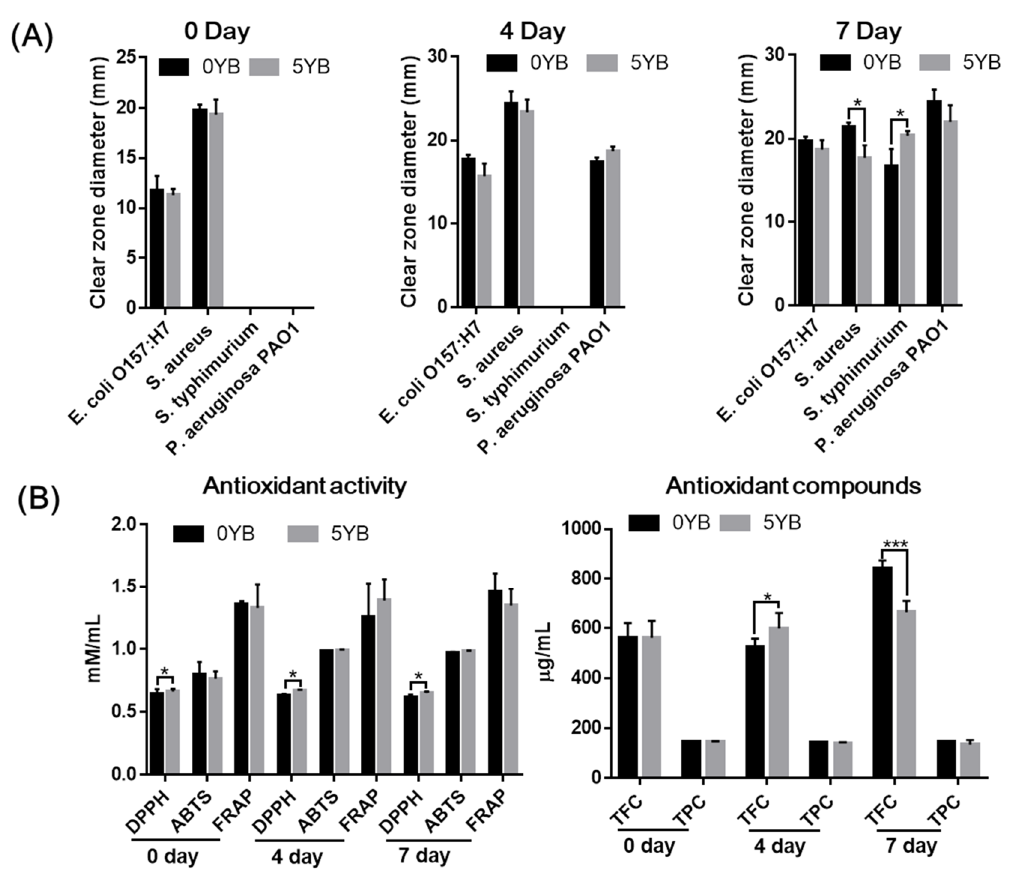
Figure 3. Antibacterial and antioxidant properties of the sterile solid-state Lp-fermented B. papyrifera (FBP) with (5YB) or without (0YB) 5% (w/w) yeast by-product supplementation. ( A ) Antibacterial activity of the FBP collected at 0 d, 4 d and 7 d; ( B ) Total antioxidant activity and antioxidant compound contents of the FBP collected at 0 d, 4 d and 7 d. * indicates significant difference between the two groups at p < 0.05. *** indicates significant difference between the two groups at p < 0.001. DPPH: 2,2 ‐ Diphenyl ‐ 1 ‐ picrylhydrazyl, ABTS: 2, 2 ′‐ azino ‐ bis (3 ‐ ethylbenzothiazoline ‐ 6 ‐ sulfonic acid), and FRAP: ferric ‐ reducing antioxidant power, TFC: total flavonoid content, TPC: total polyphenol content.